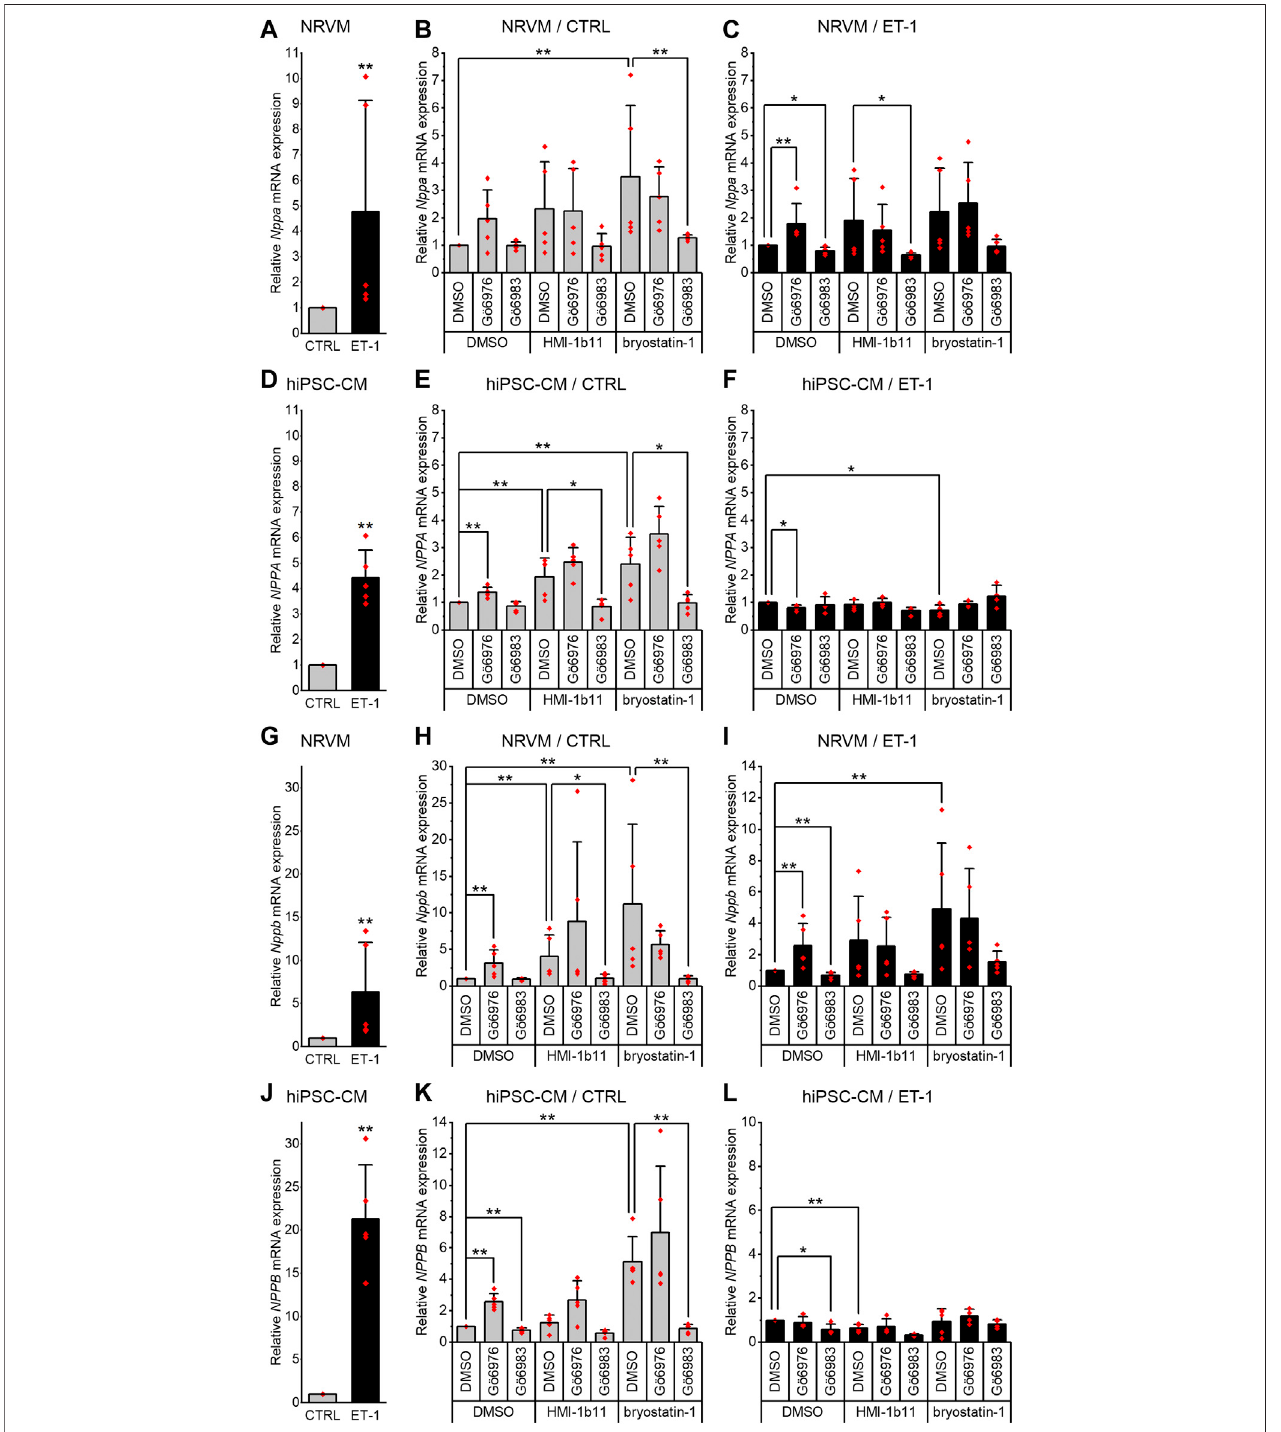
FIGURE 3 | Effects of endothelin-1 (ET-1) and pharmacological PKC modulation on hypertrophic gene expression in cardiomyocytes. Relative Nppa / NPPA (A – F) and Nppb / NPPB (G – L) expression in NRVMs and in hiPSC-CMs was measured after 24-h exposure to PKC activators (10 µM HMI-1b11 and 10 nM bryostatin-1), cPKC inhibitor (1 µM Gö6976), pan-PKC inhibitor (1 µM Gö6983) with or without 100 nM ET-1. Results are expressed as mean + SD of independent experiments with cardiomyocytesfromindividualcellisolationsordifferentiations(n (cid:2) 5forNRVMs,n (cid:2) 5forhiPSC-CMs(day31 – 52),exceptforinhibitorscombinedwithET-1n (cid:2) 4). *** p < 0.001, ** p < 0.01, * p < 0.05 as indicated (Kruskall-Wallis followed by Mann-Whitney U).